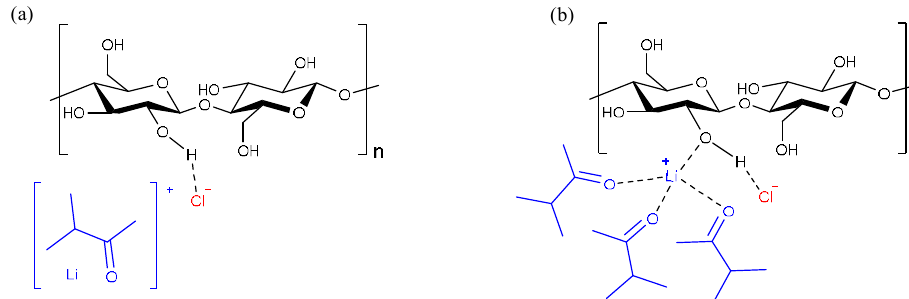
Figure 8. Proposed mechanisms of cellulose dissolving in LiCl/DMAc solution: ( a ) McCormick mechanism, ( b ) Morgenstern mechanism.